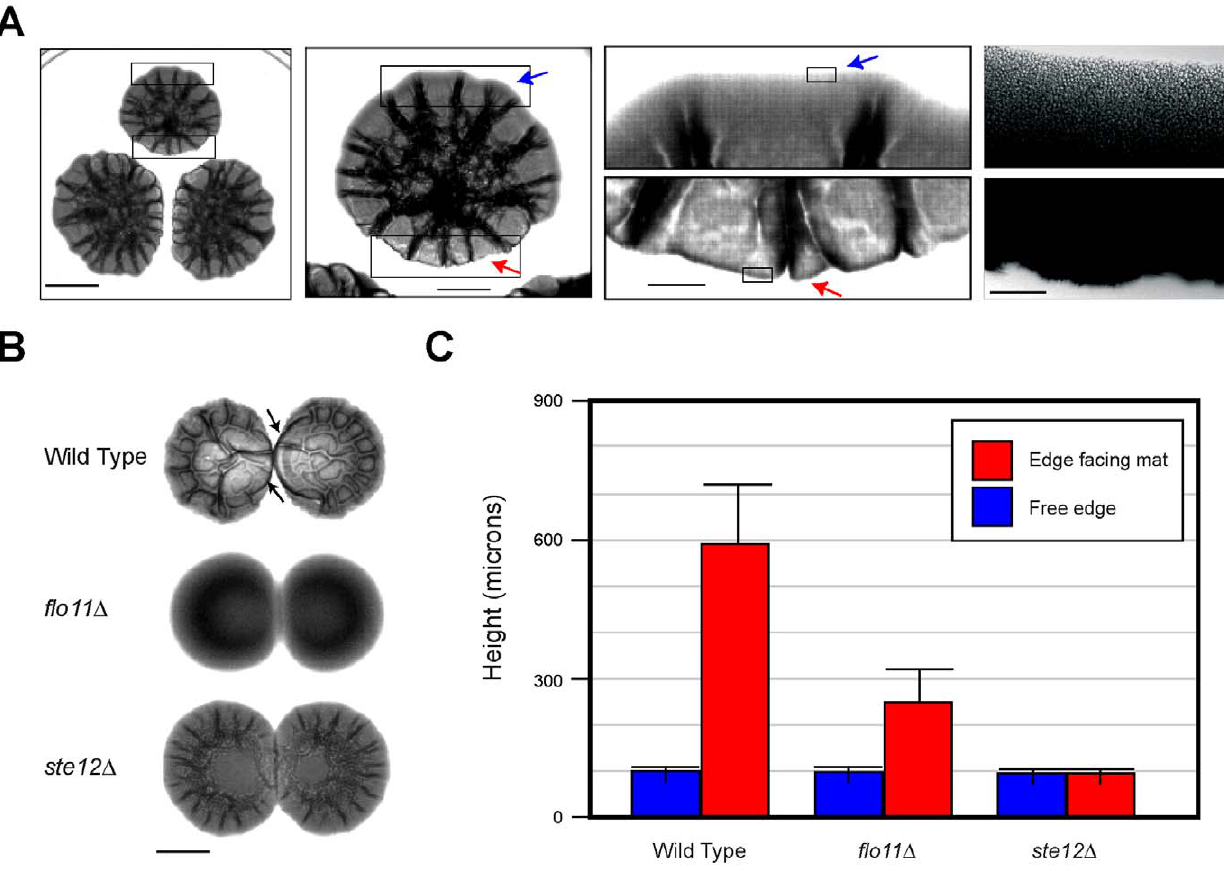
Figure 3. MAPK- and Flo11-dependent colony avoidance response. A ) Wild-type cells were spotted in three spots and examined daily. The photograph showing the embossed appearance of colonies was taken at day 3. Left three panels, Bar=1 cm. Far right panel, micrograph of cells at the perimeter of an asymmetrically forming biofilm. Bar, 200 microns. Mat borders facing (red arrows) or not facing (blue arrows) another mat are indicated. B ) Wild type (PC538), flo 11 D (PC1029), and ste 12 D (PC2382) cells were grown on YEPD media for 18 h. Equal concentrations of cells were spotted, 1 cm apart, on to YEPD media containing 0.3% agar. Plates were incubated for 48 h at 30 u C and photographed using transmitted light. Bar=1 cm. C ) Bar graph of height measurements (in mm) of the mat borders facing/not facing the adjacent mats on the right in B. Contour maps in the Z-axis of mats was generated. Seven readings after the first peak in the Z-axis were averaged to plot the graph. Standard deviation between measurements were used to generate the error